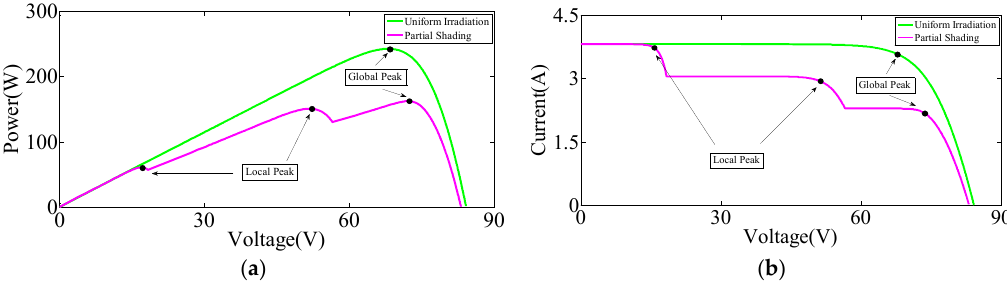
Figure 3. The output characteristics of the PV array for uniform irradiation and partial shading ( a ) P-V curve; ( b ) I-V curve.